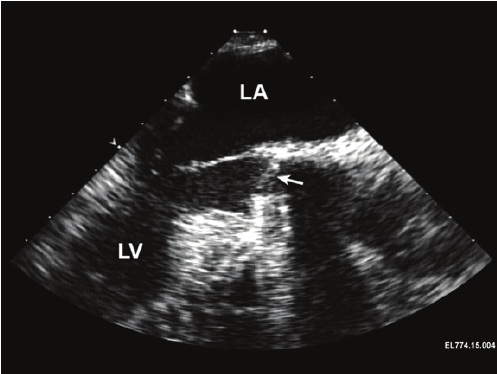
Figure 4: Intraoperative transesophageal echocardiographic view prior to replacement of the aortic valve prosthesis. This mides- ophageal aortic valve long axis view during systole demonstrates a normal-appearing St. Jude aortic prosthesis during diastole (arrow). In particular, no thrombus, pannus, or mechanical obstruction is identified. The left atrium (LA) and left ventricle (LV) are also